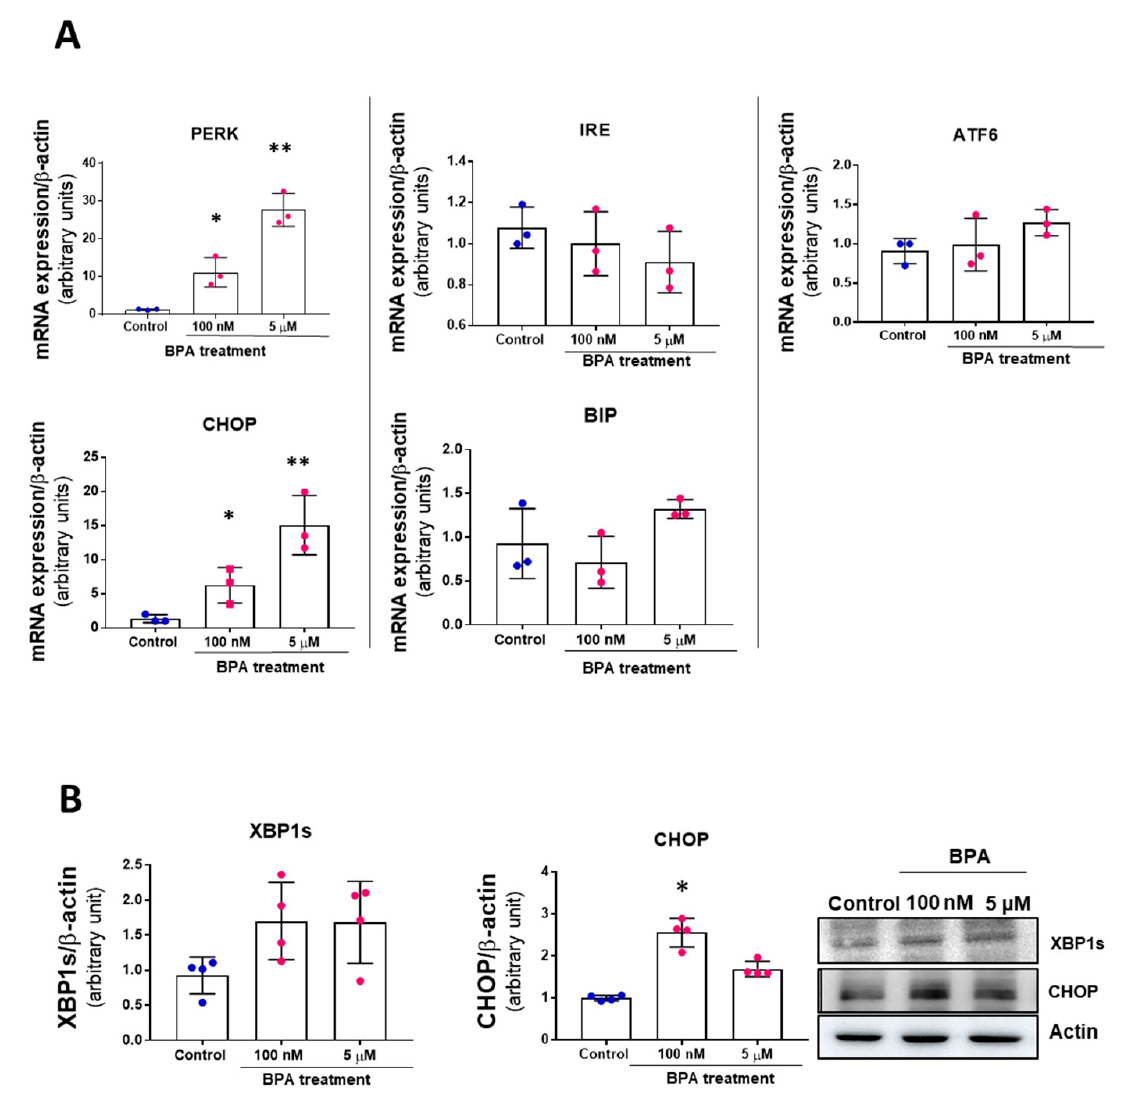
Figure 3. BPA induces the PERK/ATF4/CHOP branch of the UPR. ( A ) RT qPCR of control and 5 days BPA MAEC showing endothelial mRNA expression of PERK, IRE, ATF6, CHOP, and BIP. mRNA expression was normalized by β - actin. ( B ) MAEC were treated with 100 nM and 5 µ M BPA for five days, and XBP-1 spliced form (XBP-1s) indicative of IRE1 α activation, and CHOP protein expressions were measured by Western blot. β -actin was used as a loading control. Data represent media + SD of 4 independent experiments, each performed in duplicate. * p < 0.05 and ** p < 0.01 using Kruskal–Wallis test for the comparison between control and BPA-treated cells.